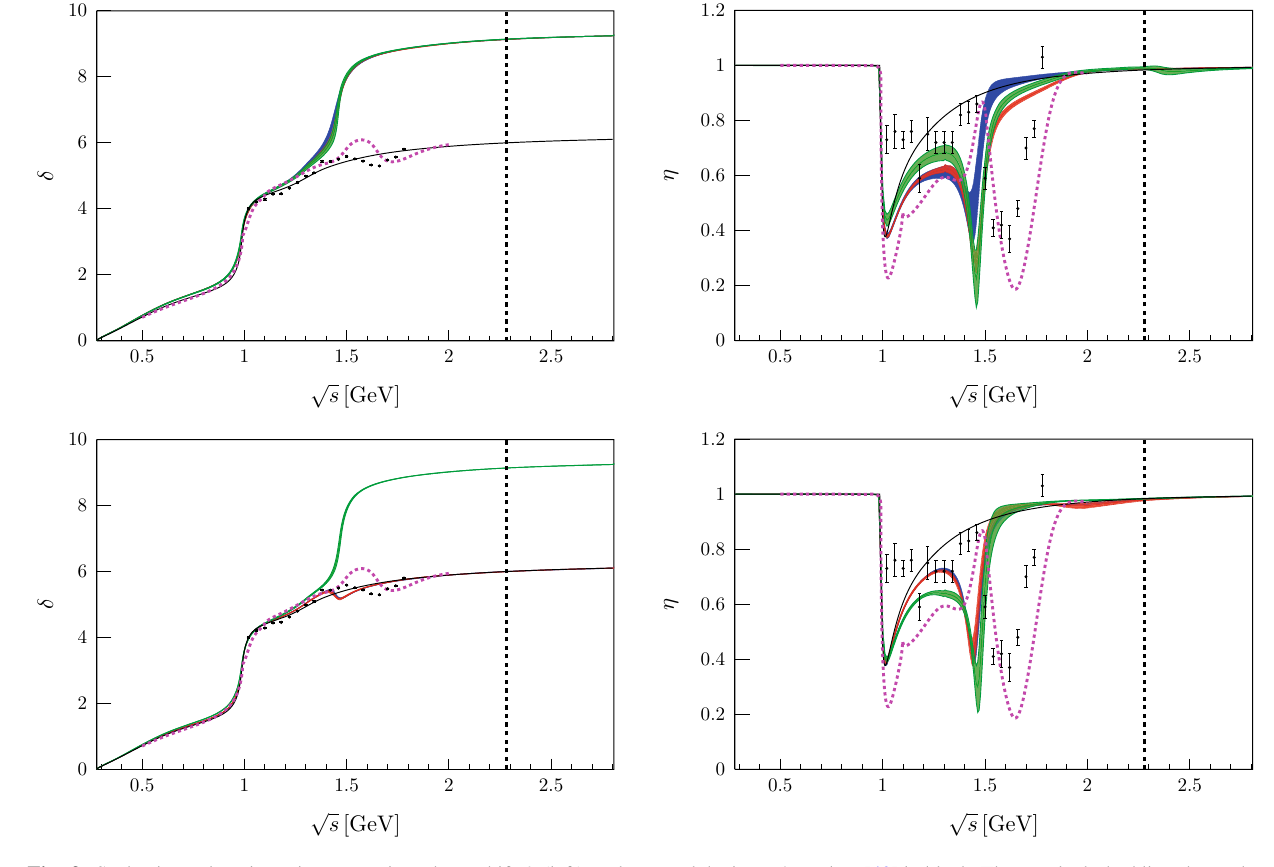
and the input δ 0 and η 0 [40] in black. The purple dashed line shows the K -matrix solution of Ref. [45]. In addition we plot the preferred phase shifts and inelasticities [7] of the CERN–Munich ππ experiment [46], which are denoted by data points with error